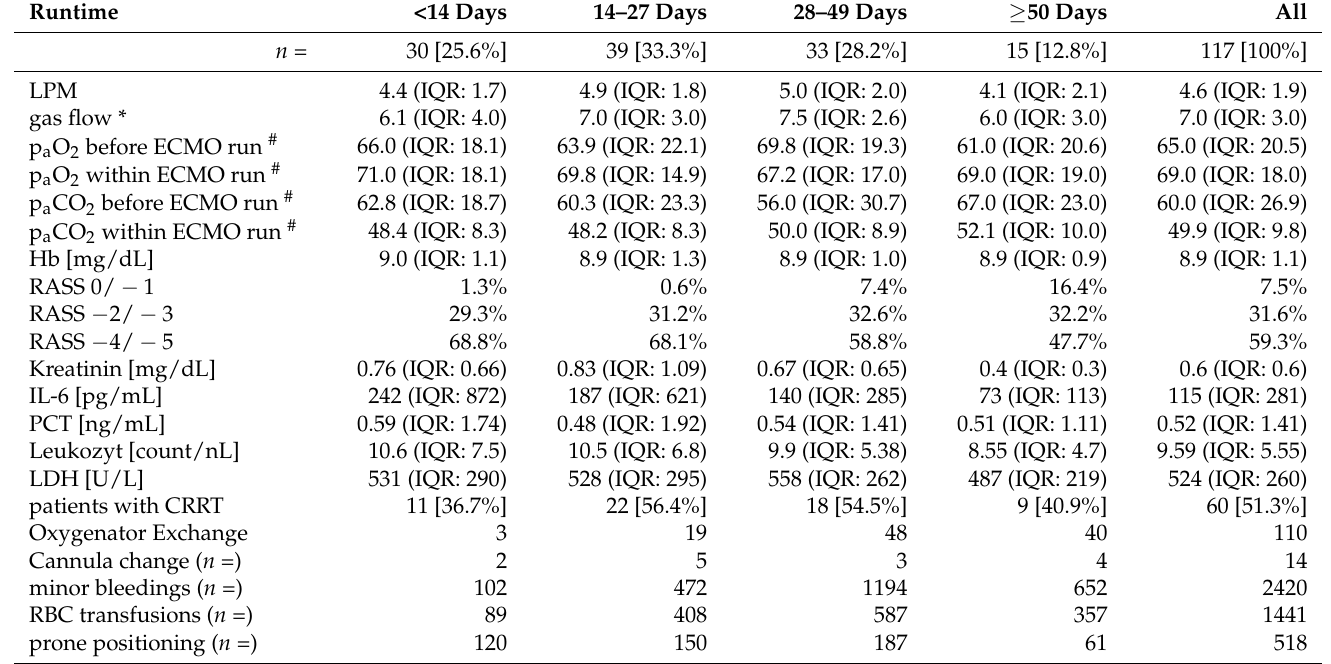
Table 3. Therapy